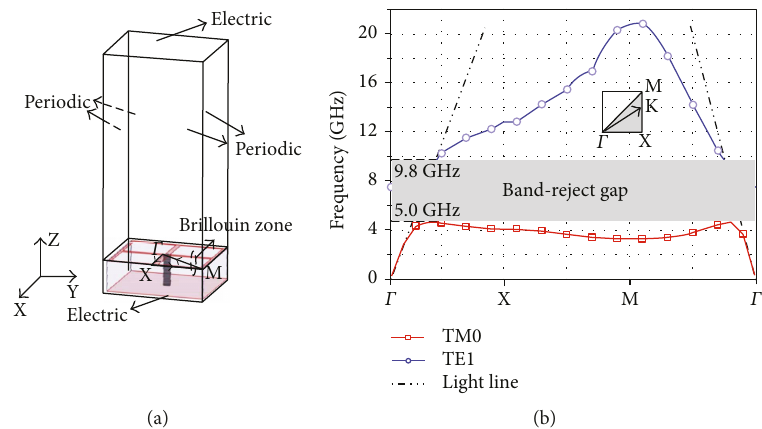
Figure 5: The band-reject gap property of the mushroom-like EBG structure. (a) The settings of a unit cell in CST MWS. (b) Simulated surface wave band structure for a unit cell.